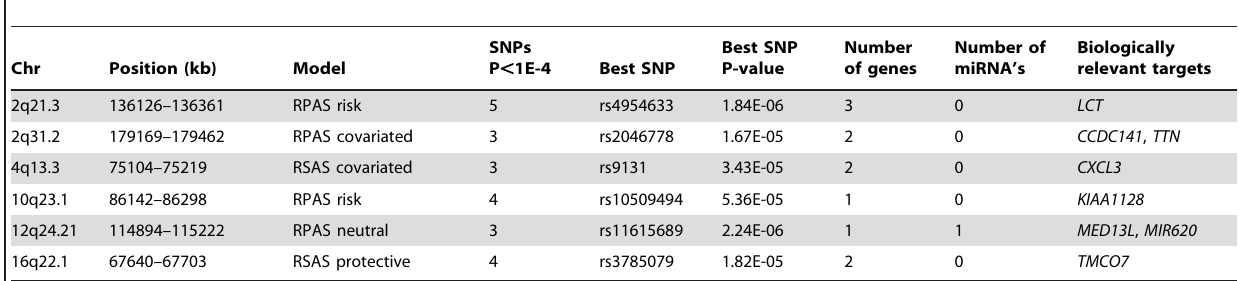
Table 1. Summary of the associated genes with biological relevance for schizophrenia or the DISC1 pathway.